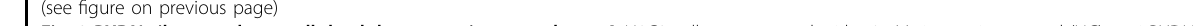
Fig. 2 PXDN silence reduces cell death by promoting autophagy. A H9C2 cells were treated with 50 μ M si-negative control (NC) or si-PXDN in serum-free medium for 24 h, and treated with 400 μ M palmitate acid (PA) or bovine serum albumin (BSA) for another 24 h. Cell survival was evaluated using fl uorescence staining with calcein acetoxymethyl ester (Calcein-AM) for live cells in green and ethidium homodimer-1 (EthD-1) for dead cells in red. The percentage of cell death was shown in the right side (scale bar = 50 μ M, n = 4). B AC16 cells were treated with si-NC or si-PXDN in serum- free medium for 24 h, and treated with PA or BSA for another 24 h. Cell survival was evaluated using fl uorescence staining. The percentage of cell death was shown in the right side (scale bar = 50 μ M, n = 4). C Autophagosomes and autolysosomes in H9C2 with si-NC or si-PXDN in the absence or presence of PA were detected by transmission electron microscopy. Black Arrow referred to autophagosomes and white arrow referred to autolysosomes. The number of autophagosomes and autolysosomes per cell was shown in the right side (scale bar = 20 μ m in top and 6 μ m in bottom, respectively. n = 3). D H9C2 cells were treated with 50 μ M si-NC or si-PXDN in serum-free medium for 24 h, and treated with 400 μ M PA or BSA with or without 1 μ M DC661 for another 24 h. PXDN, LC3II, and p62 levels were detected by Western blot and quantitative analyses were shown below ( n = 4 – 8). Data were presented as mean ± SEM. One-way ANOVA test was used. * P < 0.05, ** P < 0.01, *** P <